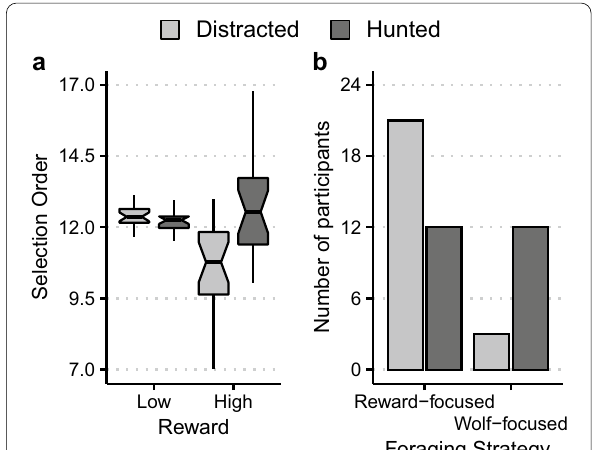
Fig. 10 a Selection Order as a function of Predation (Distracted/ Hunted) and Reward (High/Low). Horizontal lines show the central tendency (median) of each distribution, with notches indicating 95% confindence intervals. Boxes identify the upper (75%) and lower (25%) quartiles, with the whiskers indicating maximum and minimum values. b Frequency of foraging strategy as a function of Predation group in Experiment 3. See text for